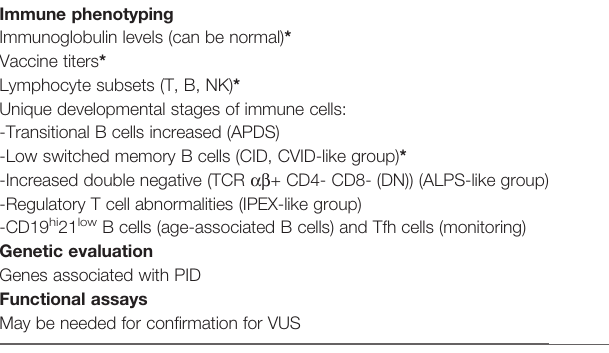
TABLE 3 | Diagnosing primary immune dysregulation disorders (PIRDs). Immune phenotyping Immunoglobulin levels (can be normal) * Vaccine titers * Lymphocyte subsets (T, B, NK) * Unique developmental stages of immune cells: -Transitional B cells increased (APDS) -Low switched memory B cells (CID, CVID-like group) * -Increased double negative (TCR ab + CD4- CD8- (DN)) (ALPS-like group) -Regulatory T cell abnormalities (IPEX-like group) -CD19 hi 21 low B cells (age-associated B cells) and Tfh cells (monitoring) Genetic evaluation Genes associated with PID Functional assays May be needed for con fi rmation for VUS ALPS, autoimmune lymphoproliferative syndrome; APDS, activated PI3K d syndrome; CID, combined immunode fi ciency; CVID, common variable immune de fi ciency; IEI, inborn error of metabolism; IPEX, immune dysregulation, polyendocrinopathy, enteropathy, X-linked (syndrome); PID, primary immunode fi ciency. *Recommended evaluation before and after cancer treatment with biological